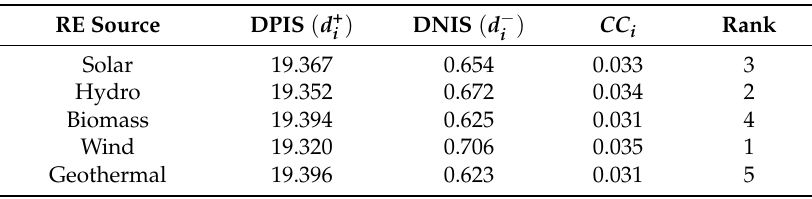
Table 9. Final ranking of the renewable